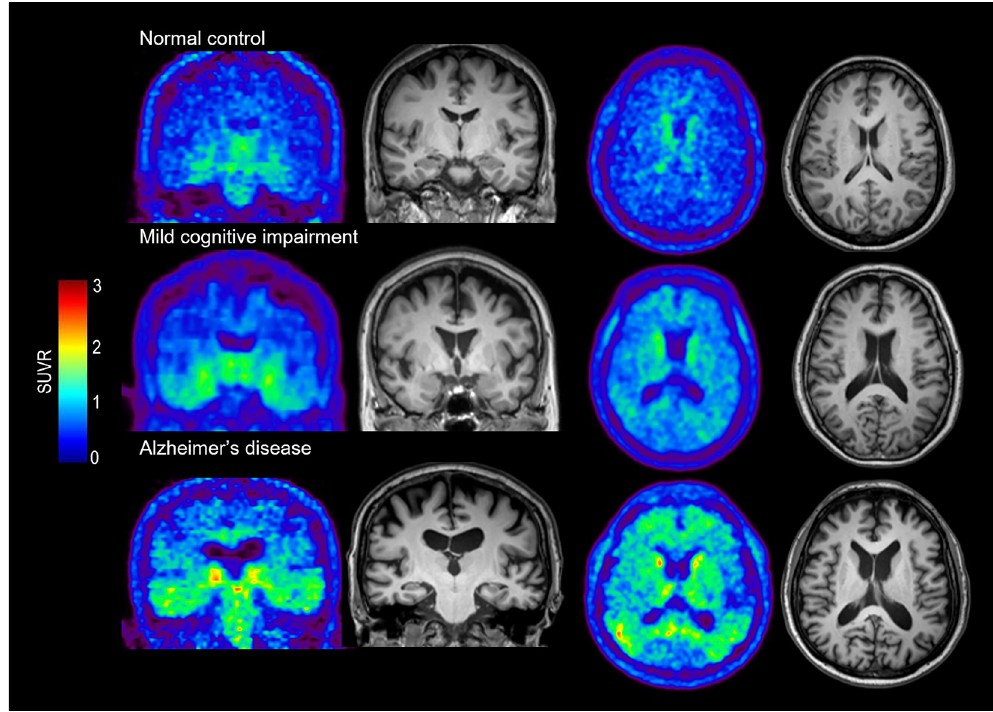
Fig 3. Representative cases of the relationship between THK5351 uptake and cortical atrophy in normal control, mild cognitive impairment, and Alzheimer’s disease. Note that the correlated locations propagate from transentorhinal to isocortical locations according to the AD